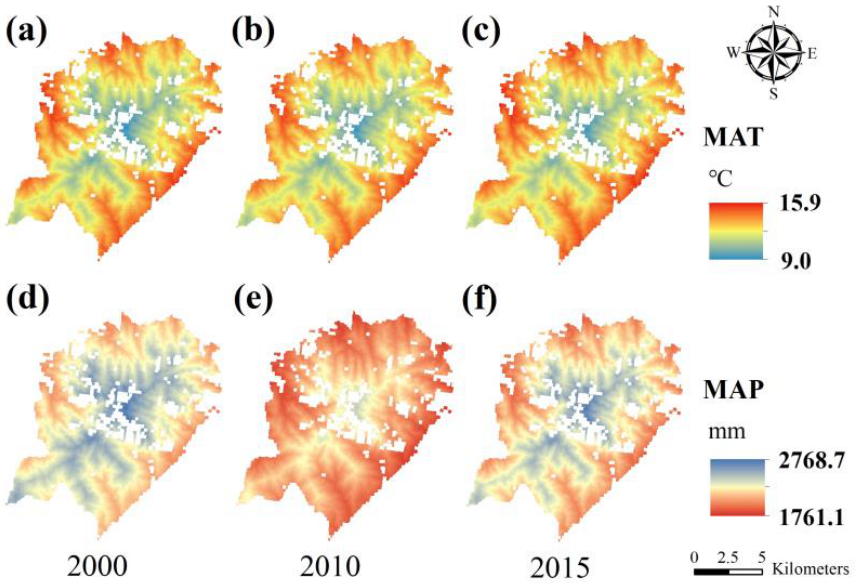
Figure A3. The vegetation indices in the Huangshan UNESCO Global Geopark: RVI in 2000 ( a ), 2010 ( b ) and 2015 ( c ); NDVI in 2000 ( d ), 2010 ( e ), and 2015 ( f ); MSAVI in 2000 ( g ), 2010 ( h ), and 2015 ( i ); and MTVI2 in 2000 ( j ), 2010 (k), and 2015 ( l ).